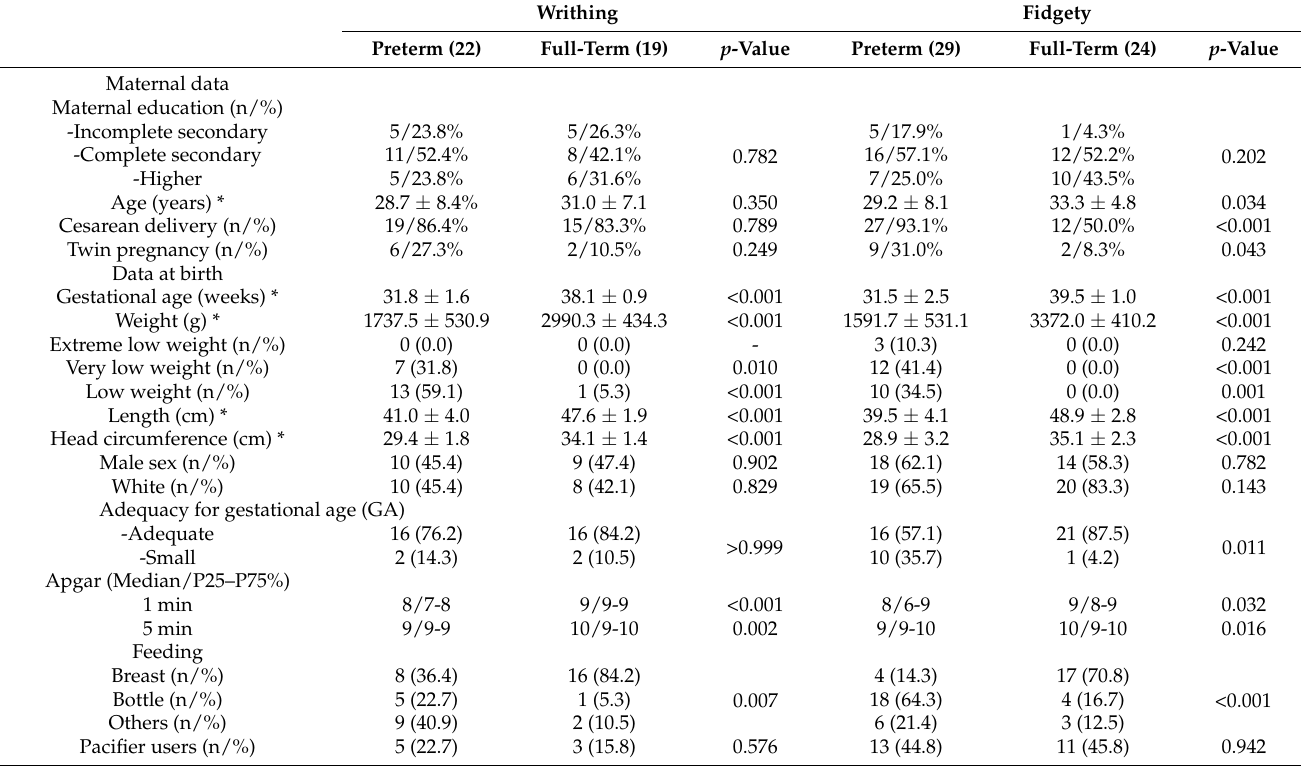
Table 1. Maternal, birth, and infants’ data according to GMs period and gestational age at birth. Writhing Fidgety Preterm (22) Full-Term (19) p -Value Preterm (29) p -Value